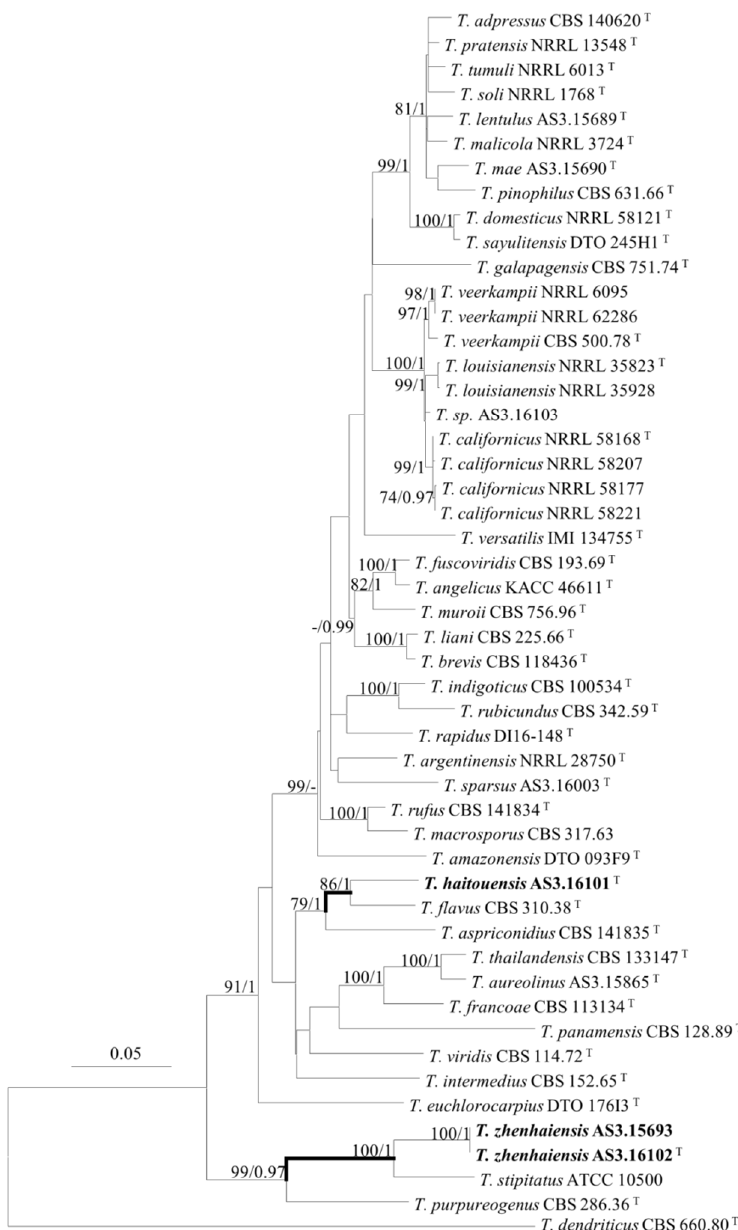
Figure 1. ML phylogram inferred from the concatenated BenA-CaM-Rpb2 sequences. Bootstrap percentages over 70% derived from 1000 replicates and posterior probabilities over 0.95 of BI are indicated at the nodes. T indicates ex-type strains, strains belonging to new species are indicated in boldface. Scale Bar: number of substitutions per nucleotide position.